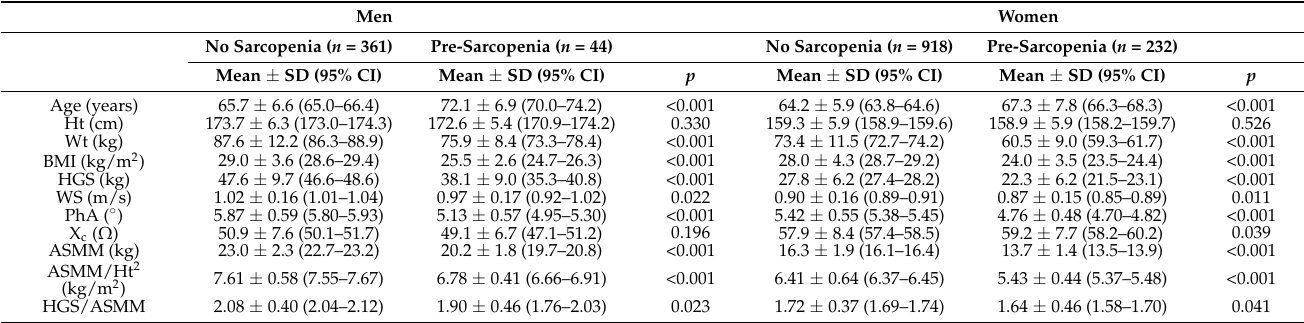
Table 1. Descriptive characteristics of study